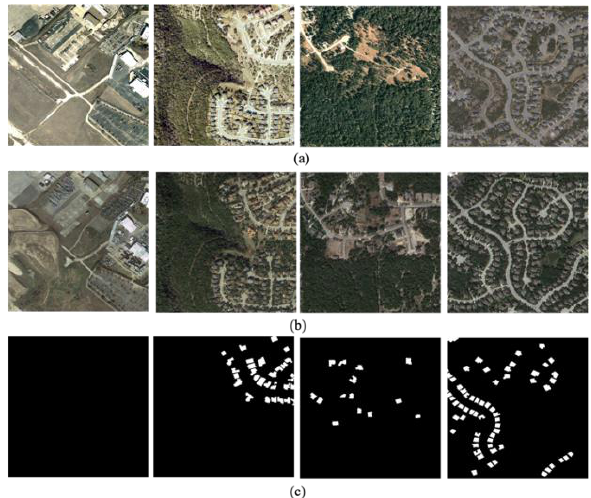
Figure 4. Samples from the LEVER-CD dataset. (a) Images at older point in time. (b) More recent images of the same location. (c) Ground truth depicting the changed area.